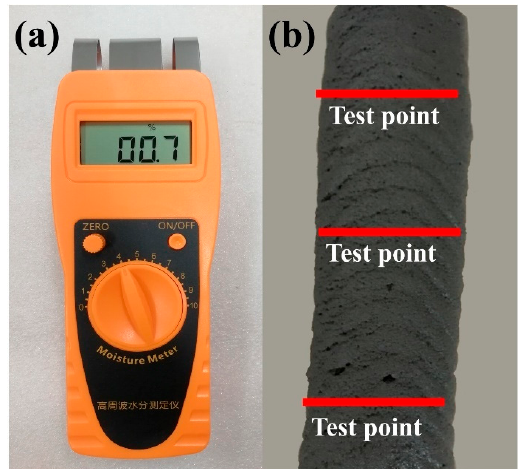
Figure 5. Surface moisture of 3D printed layer. ( a ) JK-C10 Moisture meter; ( b ) randomly selected three test points to measure the surface moisture value.